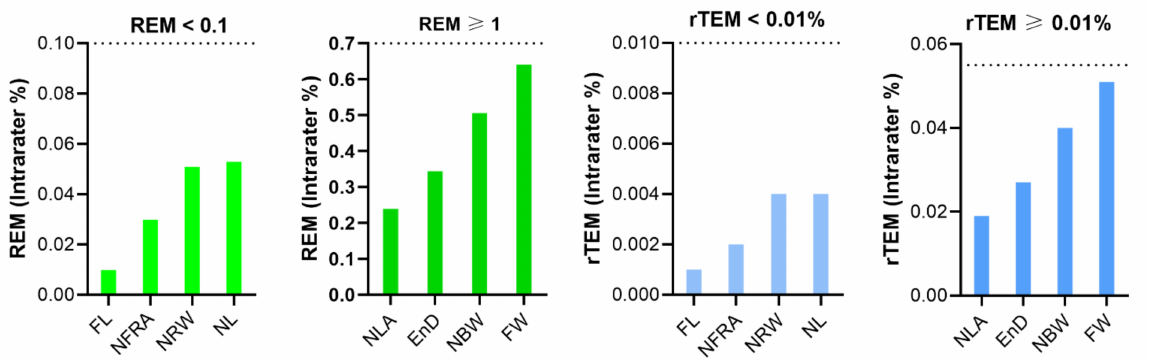
Figure 5. Intra-assessor relative error measurement (REM) and relative technical error of measure- ment (rTEM) of classical nasal measurements on three-dimensional